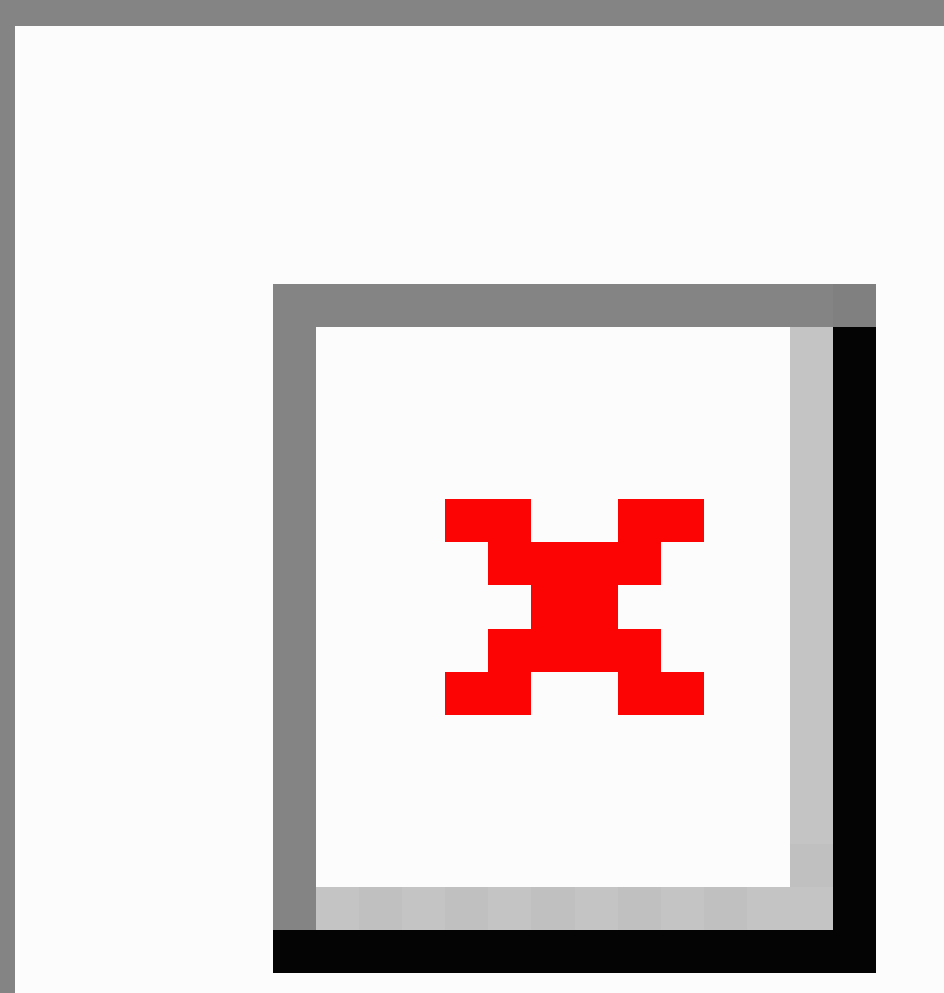
Figure 2. Number of posts and EdgeRank scores for the study period by month and